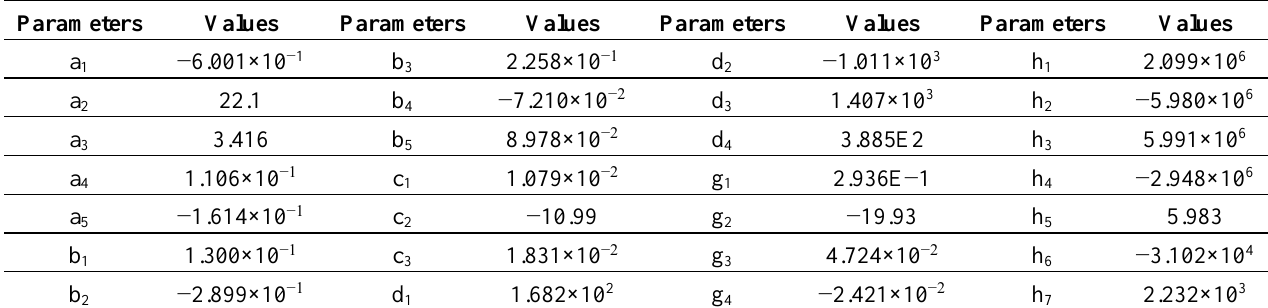
Table 1. Impedance parameters for a new